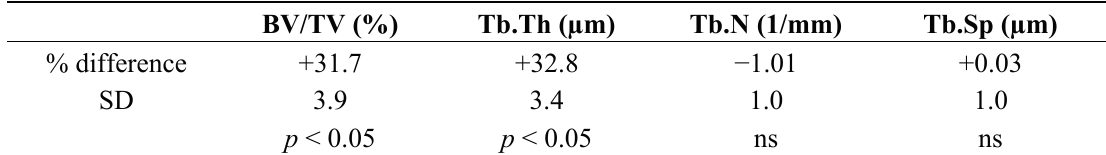
Figure 5. Densitometric analysis of the vertebral bodies from the thoracic region. (A) Percent bone volume (BV/TV) was determined for each thoracic vertebral body and values were averaged among six wild-type and three Col11a1 − / − e17.5d embryos. Col11a1 − / − (grey) vertebral bodies had a greater percent bone volume consistently comparer to wild-type littermates (black). ( B ) Trabecular thickness (µm) was determined for each thoracic vertebral body and values were averaged among six wild-type and three Col11a1 − / − e17.5d embryos. Trabecular thickness was consistently greater in the Col11a1 − / − embryos compared to wild-type littermates. ( C ) Trabecular number (1/mm) was determined for each thoracic vertebral body and values were averaged among six wild-type and three Col11a1 − / − e17.5d embryos. No significant difference in trabecular number was observed between wild-type and Col11a1-deficient embryos. ( D ) Trabecular separation (µm) was determined for each thoracic vertebral body and values were averaged among six wild-type and three Col11a1 − / − e17.5d embryos. While no significant difference in trabecular separation was observed between wild-type and Col11a1-deficient embryos for many of the individual vertebral bodies, there are some for which a significant decrease was detected. Error bars represent ± SD. Average values of all differences are presented in Table 2. Table 1. Densitometric indices for the vertebral arches (mean % difference ± SD) between WT and Col11a1 − / −